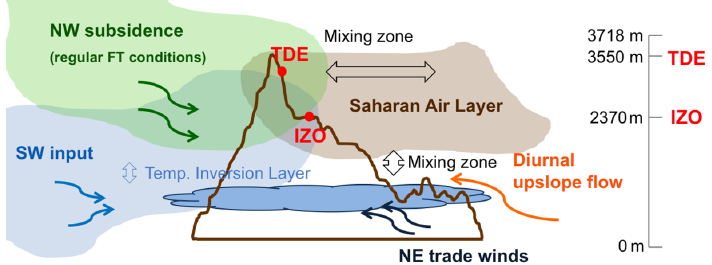
Figure 1. Schematic depiction of the processes influencing the water vapour balance over Tenerife in the subtropical North Atlantic. A tem- perature inversion layer separates the marine boundary layer (MBL) and the free troposphere (FT). In the MBL, NE trade winds blow, while in the FT, the regular NW subsidence regime is alternated in summer with Saharan dust outbreaks. On the island, the upslope winds prompt MBL air to reach the low FT during the daytime. IZO and TDE stations are represented as red